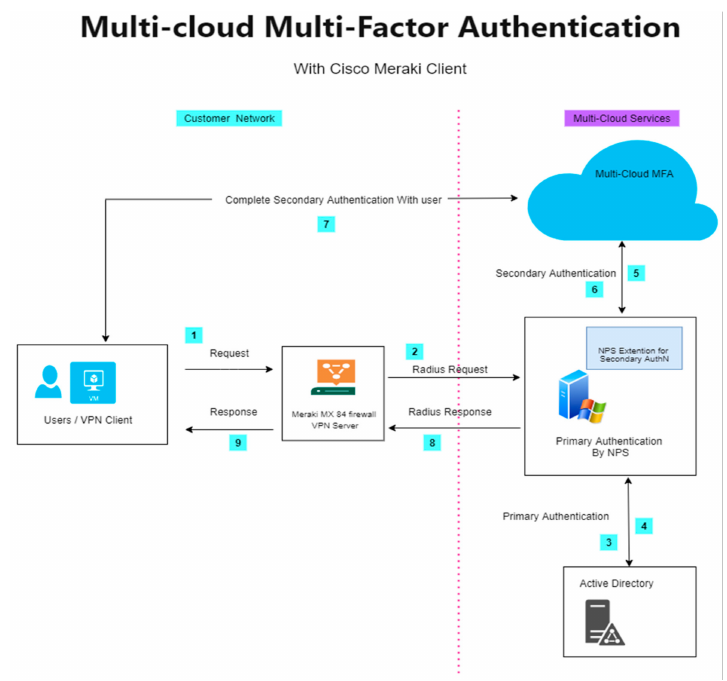
Figure 4. MFA implementation with azure and cisco. NPS, network policy server. SMS: The user receives an SMS on a given cell number and put this SMS OTP into a required field. We do not use this option as Meraki Client firewall servers no longer support SMS-based